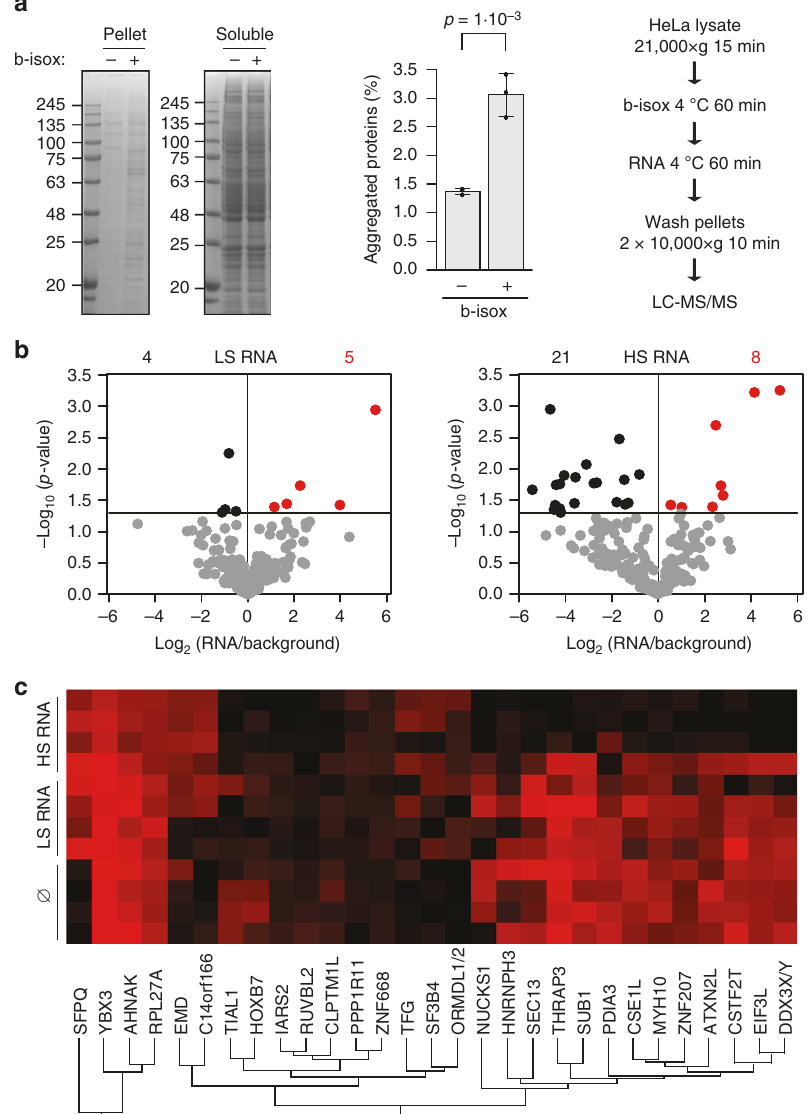
Fig. 4 Structured RNA reduces protein aggregation in vitro. a Biotinylated isoxazole (b-isox)-driven aggregation of HeLa protein lysate in vitro. Left, Coomassie-stained gels, one representative experiment shown (uncropped gels are presented in the Supplementary Fig. 10). Centre, aggregated protein intensity was quanti fi ed and the difference evaluated using two-tailed t test ( p = 1 ×1 0 – 3 ; N = 3 biological replicates shown as dots in the image). S.d. is shown. Right, experimental scheme. The aggregation ef fi cacy was tested by comparing the resultant precipitate in the presence or absence of b-isox, this is indicated by a + or a – , respectably. b Volcano plots indicate the p values (Perseus measure) of the individual protein enrichments in b-isox assembly ( N = 4 independent biological replicates). The statistical signi fi cance threshold is marked by a horizontal line (see also Supplementary Data 5). Black dots are proteins with signi fi cantly decreased concentration after the RNA incubation. Red dots are proteins with signi fi cantly increased concentration after the RNA incubation. c Colour-coded label-free quantitation (LFQ) intensities of proteins affected by the high structured (HS) RNA on a scale from black (low) to red (high). Hierarchical clustering by Perseus is indicated. For comparison, the LFQ intensities of the same proteins in control and in the presence of the LS RNA are plotted as